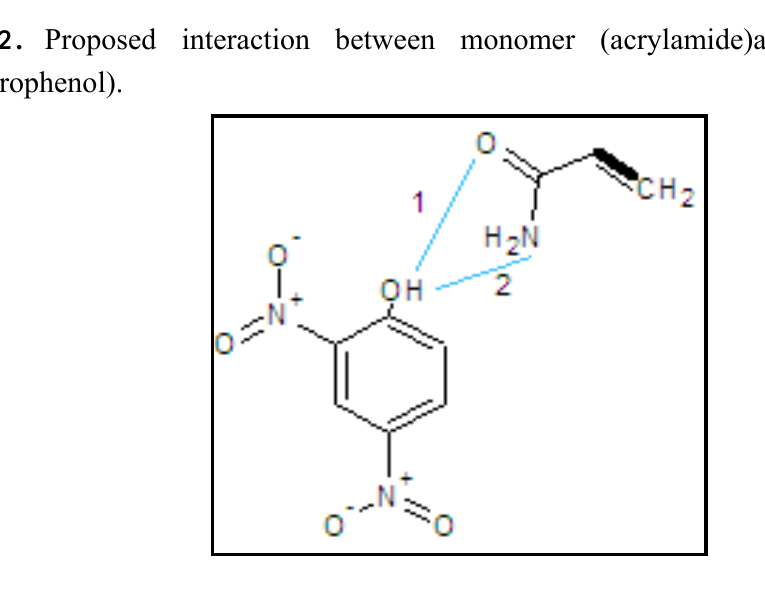
Figure 3. The MIP particles size using a Nanophox particle size